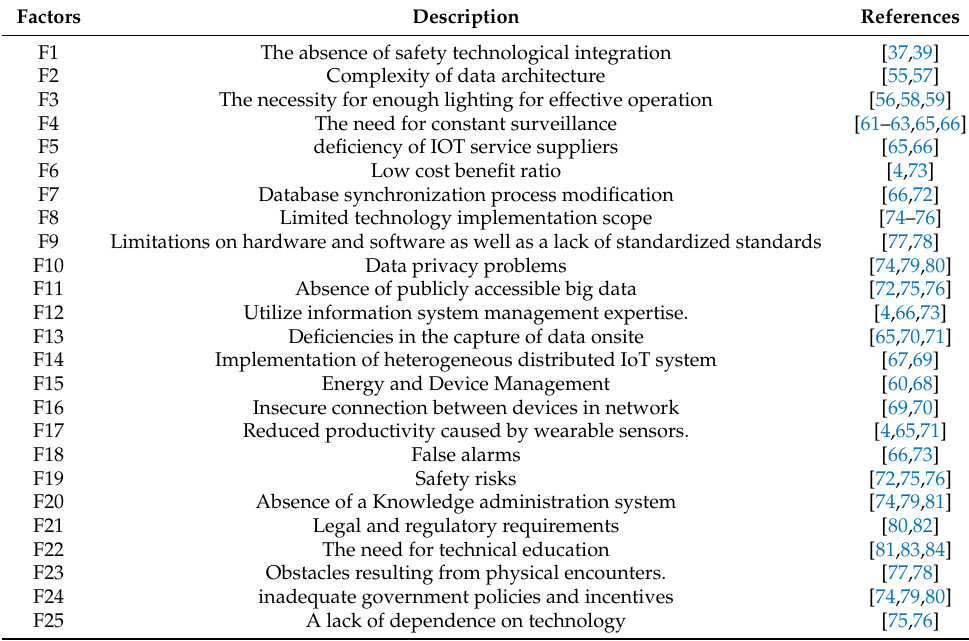
Table 1. Challenges of IOT